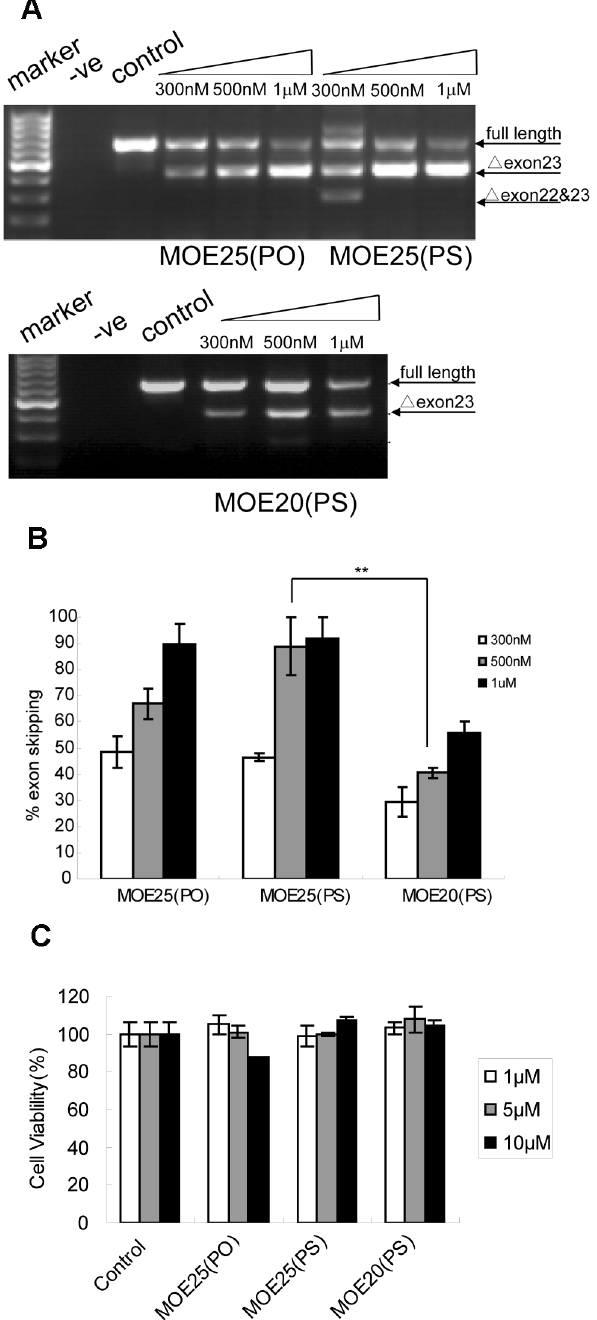
Figure 1. Dose-dependent analysis for different MOE AOs in H 2 K mdx cells. (A) RT-PCR results for different MOE AOs in H 2 K mdx cells at different concentrations from 300 nM to1 m M. D Exon 23 represents exon 23 skipped PCR product; D Exon 22&23 indicates both exon 22 and exon 23 skipped PCR product. (B) Quantification of percentage of exon 23 skipping for different MOE AOs at different concentrations. The data show higher activity with MOE25(PS) than that of MOE20(PS) AOs at a concentration of 500 nM (n=6, **p , 0.001). (C) A WST-8 cytotoxicity assay for tested AOs in H 2 K mdx cells with AO concentrations up to 10 m M.